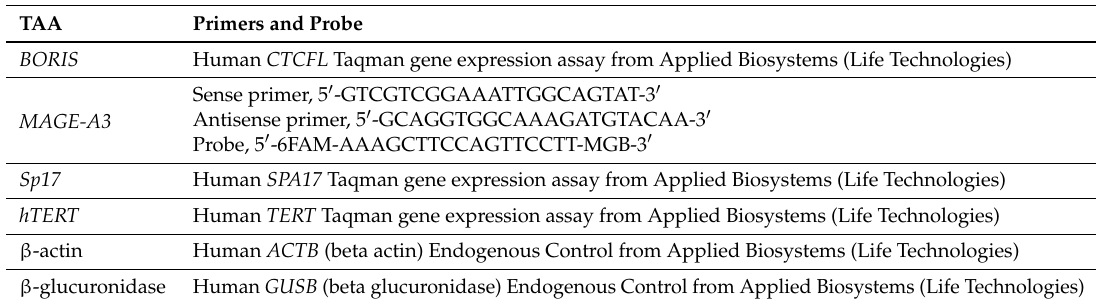
Table 3. Primers used for